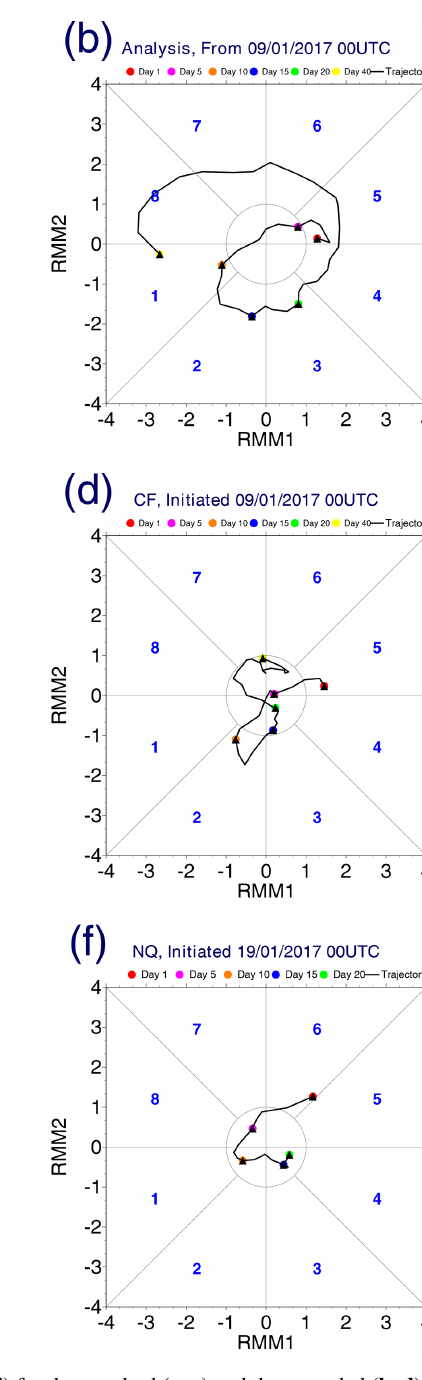
Figure 7. RMM plots for the analysis (a, b) and for control forecasts (c, d) for the standard (a, c) and the extended (b, d) forecast cases. The Ma (e) and NQ (f) cases for the standard forecast are also